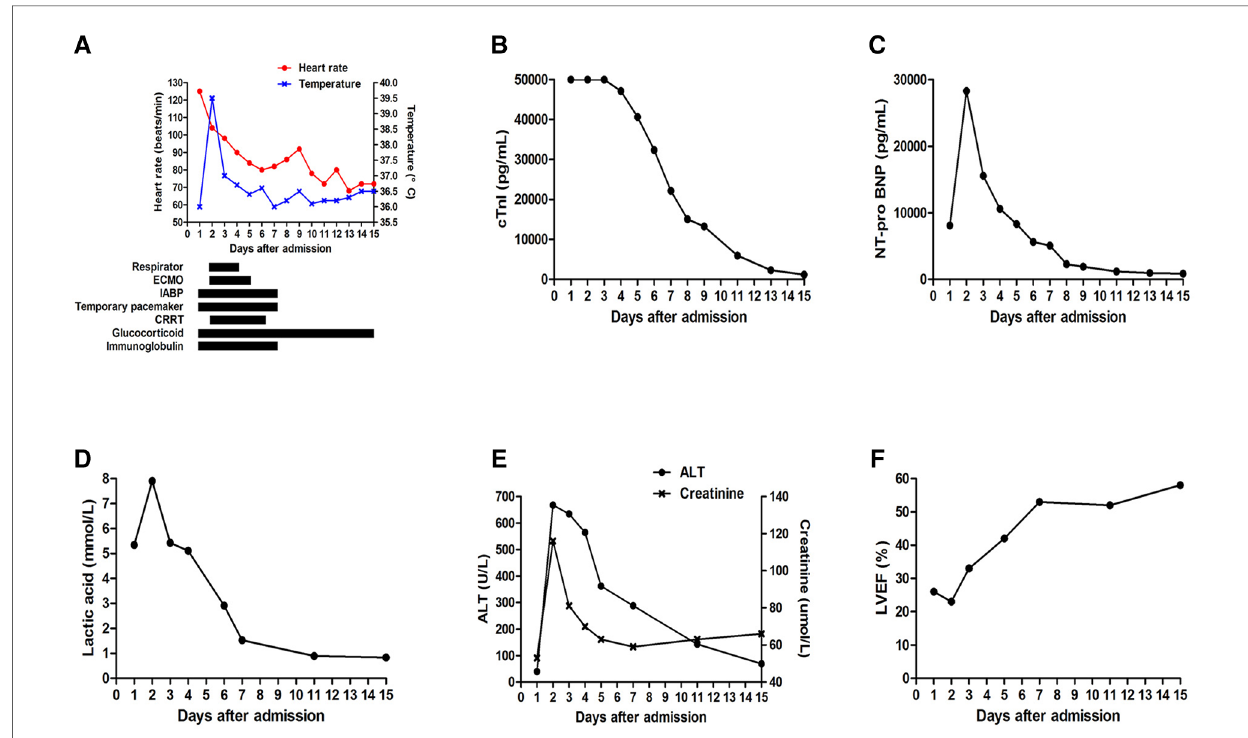
FIGURE 3 ( A ) Combined treatment of IABP, VA-ECMO, temporary pacemaker, respirator, CRRT with immunosuppression therapy. Changes in ( B ) cTnI, ( C ) NT pro- BNP, ( D ) lactic acid, ( E ) ALT and creatinine, ( F ) LVEF during